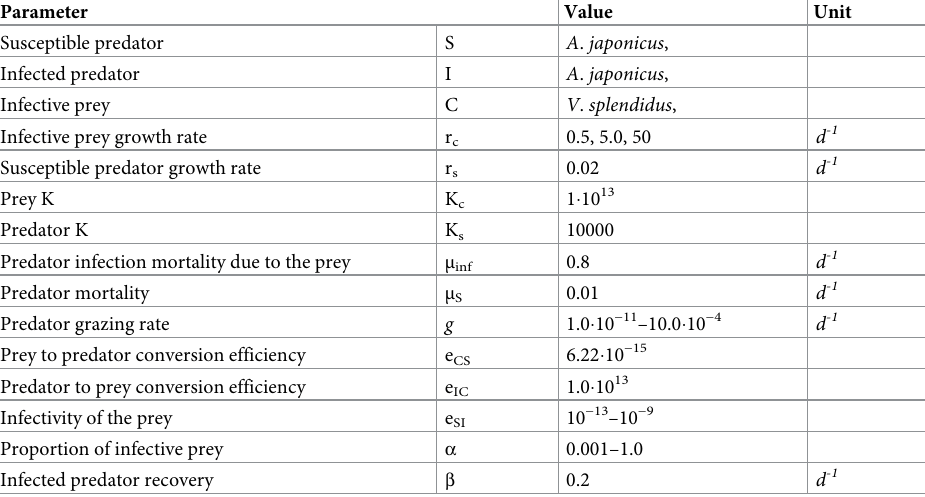
Table 1. Symbols and parameter